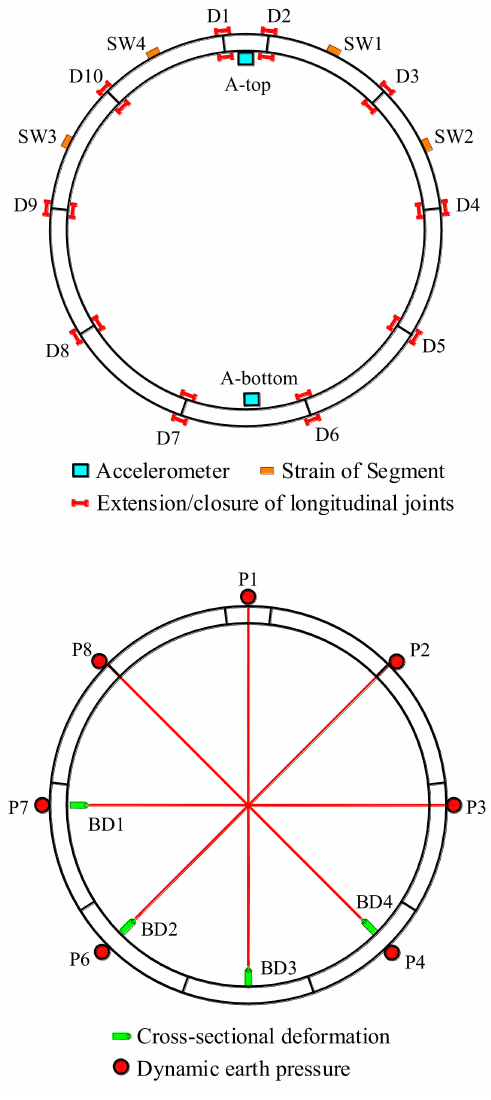
Figure 9. Sensors on the model